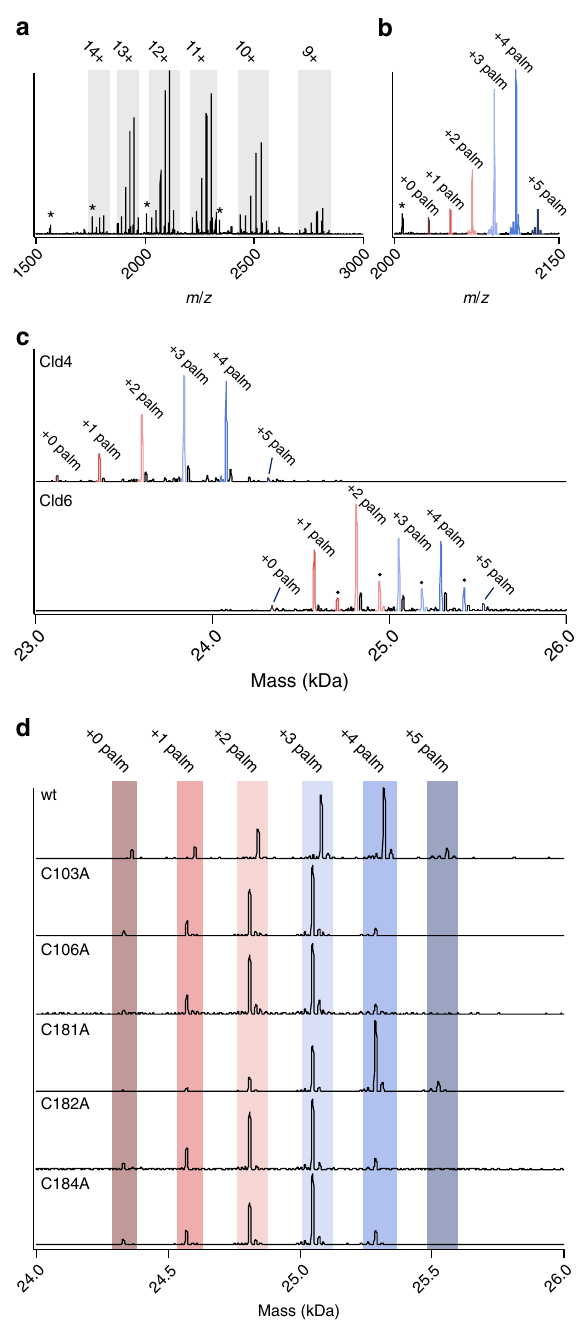
Fig. 1 Native mass spectra of micelle-released poly-palmitoylated claudins. a Spectrum of Cld3 in complex with C-CPE, showing a mass distribution corresponding to Cld3 harboring zero to fi ve attached palmitates. Gray boxes contain Cld3 peaks with the corresponding charge state annotated. Peaks labeled with an asterisk represent C-CPE peaks. All panels in this fi gure show representative data from biological triplicates. b Close up of the 12 + Cld3 charge state with the number of palmitates bound to Cld3 annotated for each peak. c Deconvoluted native ESI-MS spectra of poly- palmitoylated Cld4 and Cld6. The Cld6 peaks annotated with a dot correspond to a Cld6 mass without its initiator methionine removed. d Deconvoluted spectra of native Cld3 and of Cld3 with putative palmitoylated cysteines mutated to alanine one by one, showing that mutation of Cys 103, 106, 182, or 184 to Ala result in the loss of a single palmitate, whereas mutation of Cys 181 does